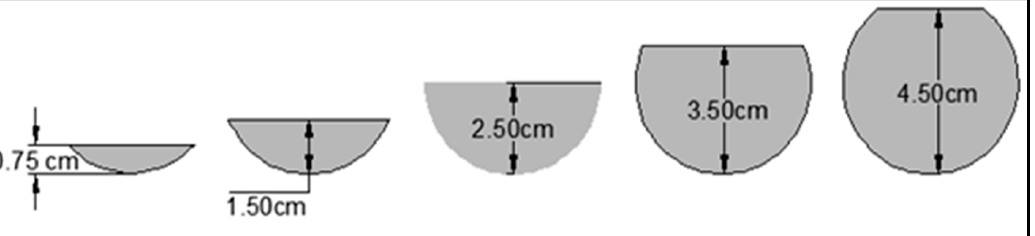
Figure 6. The outfall of the experimental flume.